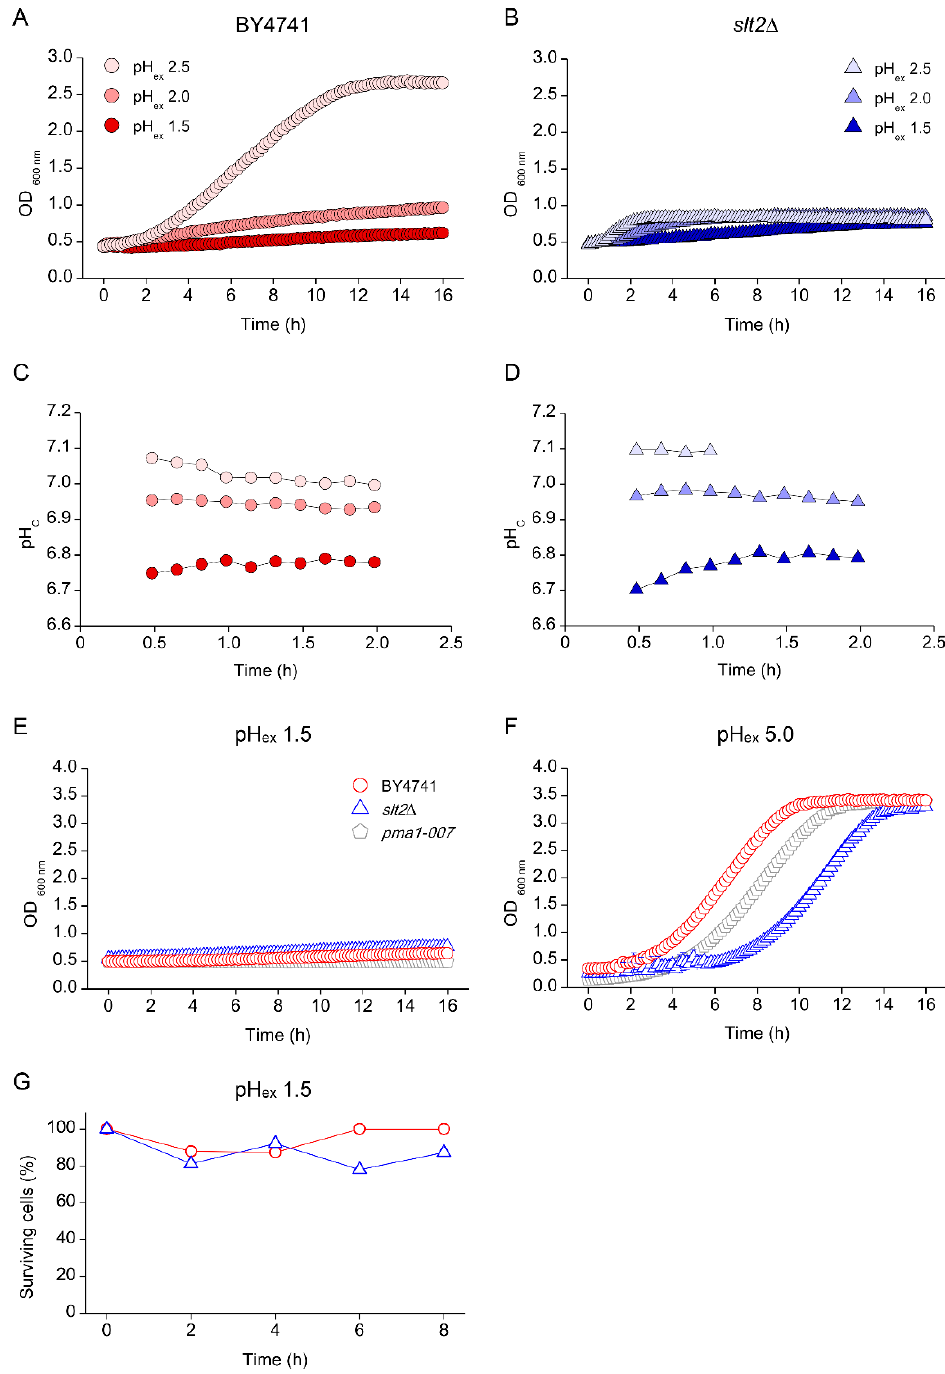
Figure 6. Effect of extreme low external pH (pH ex ) on growth profile S. cerevisiae. Cells of BY4741 wild type strain (red circles) and its isogenic mutants slt2 ∆ (blue triangles) were cultivated in YNB adjusted with sulphuric acid to pH 2.5 (light red or blue), pH 2.0 (medium red or blue) or pH 1.5 (dark red or blue) and growth profile ( A , C ) and cytosolic pH (pHc) ( B , D ) were defined. Afterwards, BY4741 (red circles) and its isogenic mutants slt2 ∆ (blue triangles) and pma1-007 (grey pentagon) were cultivated in YNB adjusted to pH 1.5 ( E ) and at the end of cultivation their cells were transferred to YNB pH 5.0 ( F ). Cells were collected at di ff erent times of cultivation in YNB pH 1.5 ( E ) and tested for the percentage of viable cells ( G ).